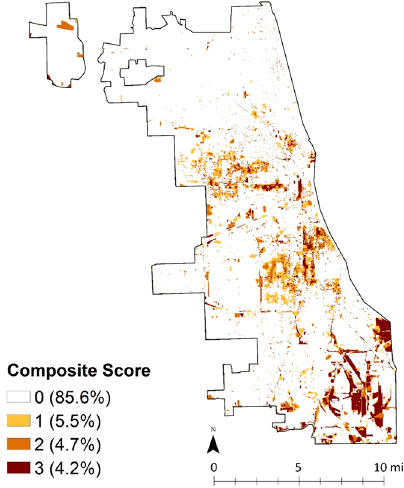
Figure 6. Overlap of all three scenarios for 2020 vacant land predictions in Chicago, IL.